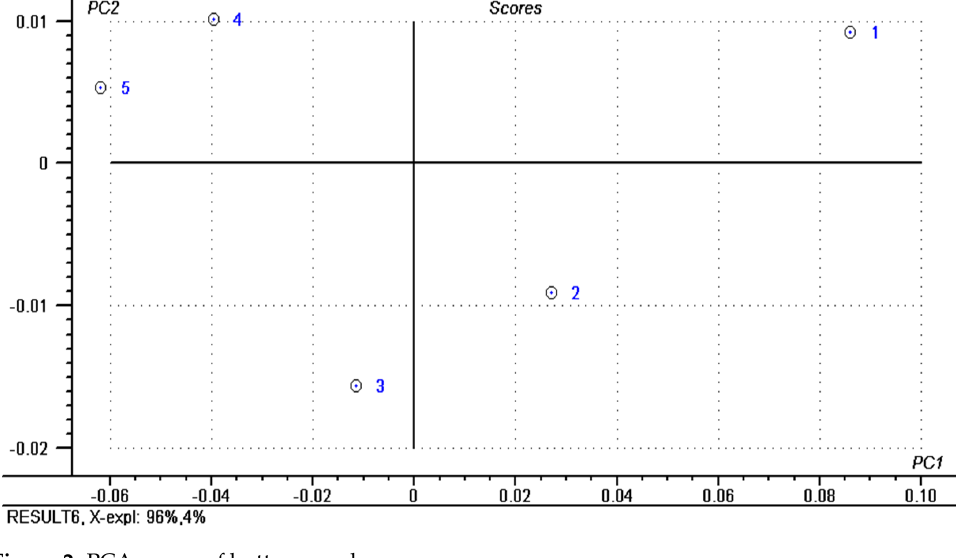
Figure 2. PCA scores of butter samples.